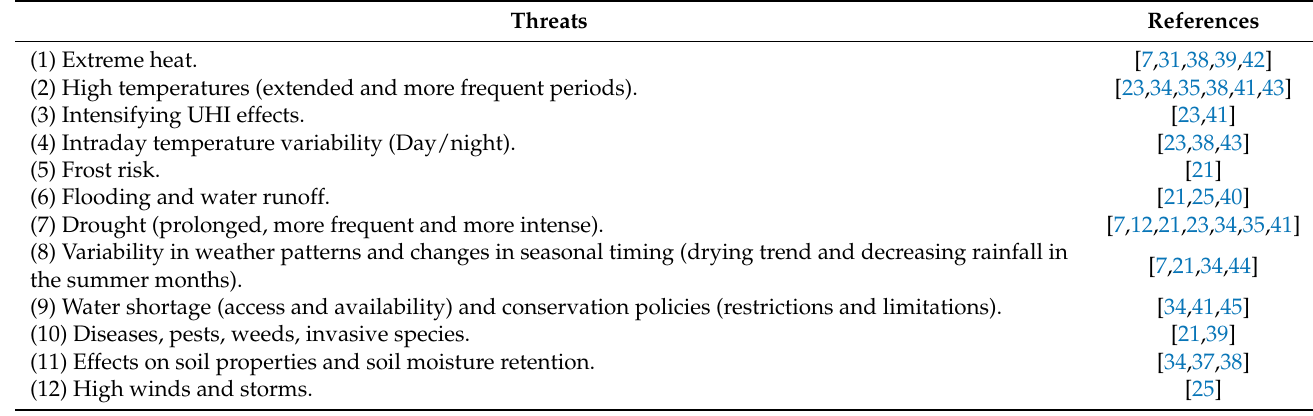
Table 2. Main climate change threats to urban gardens.